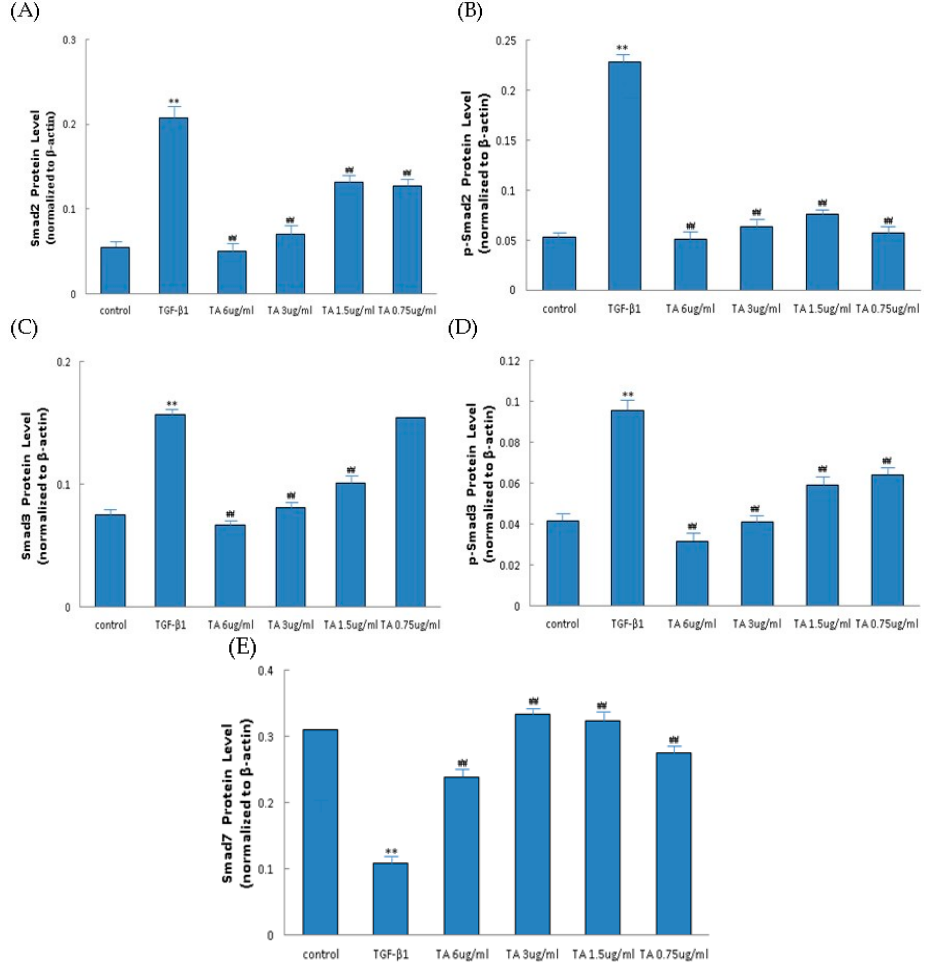
Figure 8. Effects of acteoside on the protein expression of smad2, p-smad2, smad3, p-smad3 and smad7 in HSC. ( A ) Smad2 protein level; ( B ) P-smad2 protein level; ( C ) Smad3 protein level; ( D ) P-smad3 protein level; ( E ) Smad7 protein level. Data were expressed as mean ± SD. ** p < 0.01 compared with control group, ## p < 0.01 compared with TGF- β 1 group.